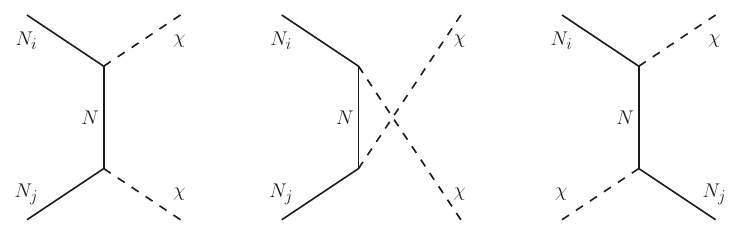
Figure 9 . The scattering processes with the new scalar coupling ξ